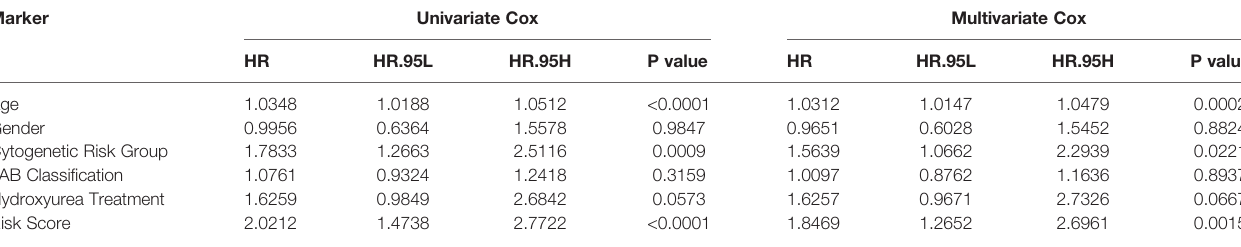
TABLE 4 | Identi fi cation the independent prognostic value of survival model and clinic characters through univariate Cox regression and multivariate Cox regression. Marker Univariate Cox Multivariate Cox HR HR.95L HR.95H P value P value